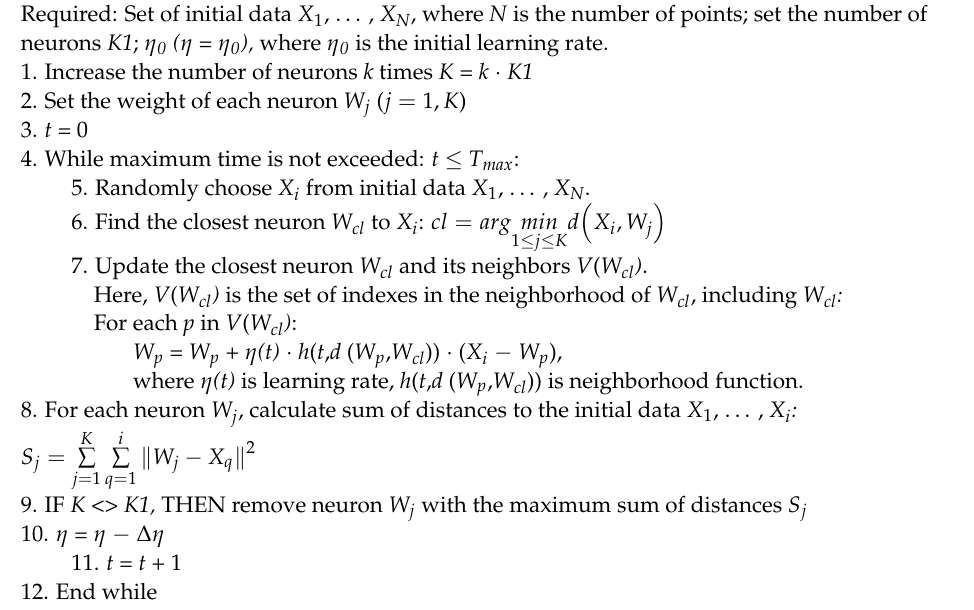
Algorithm 4. SOM-based algorithm with a greedy agglomerative heuristic (SOM-GREEDY) Required: Set of initial data X 1 , . . . , X N , where N is the number of points; set the number of neurons K1 ; η 0 ( η = η 0 ), where η 0 is the initial learning